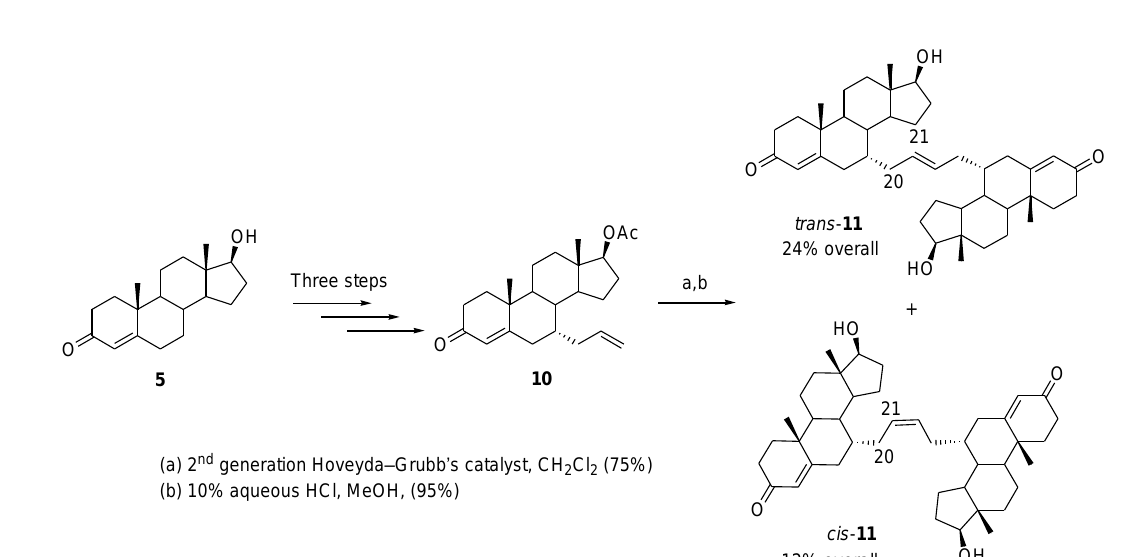
Figure 4. Synthesis of 7 α -allyl testosterone acetate ( 10 ) and testosterone dimers trans- 11 and cis- 11 via an olefin metathesis reaction.